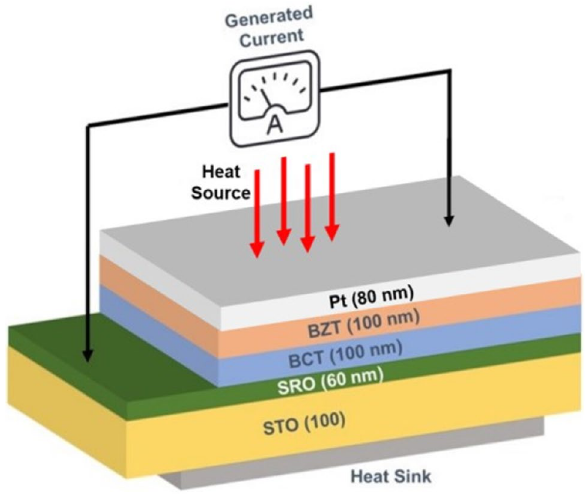
Figure 1. Schematic of the capacitive structure of a pyroelectric device.